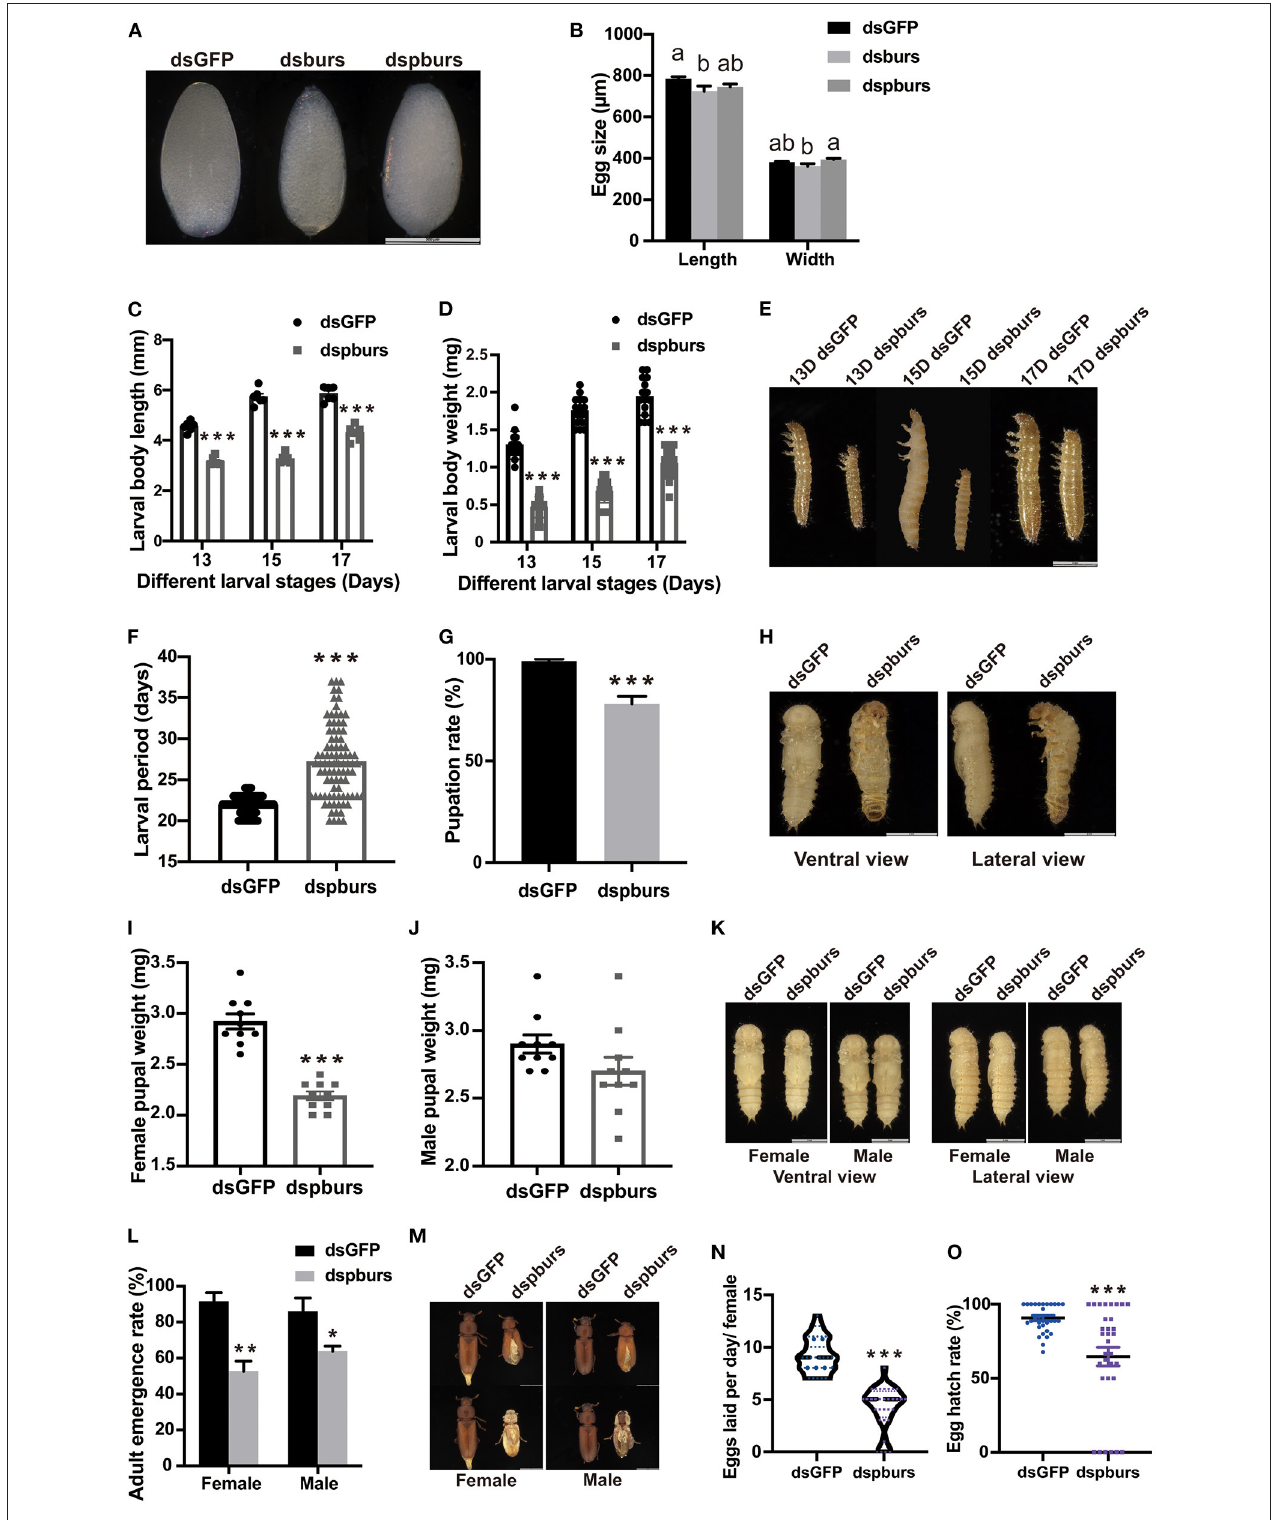
FIGURE 5 | Impacts of pburs RNAi on offspring growth and development. (A) Morphology and (B) length and width of eggs from dsGFP-, dsburs-, and dspburs-treated groups. (C) Body length, (D) body weight, and (E) morphology of 13-, 15-, and 17-day F1 larvae from dsGFP- and dspburs-treated groups. (F)